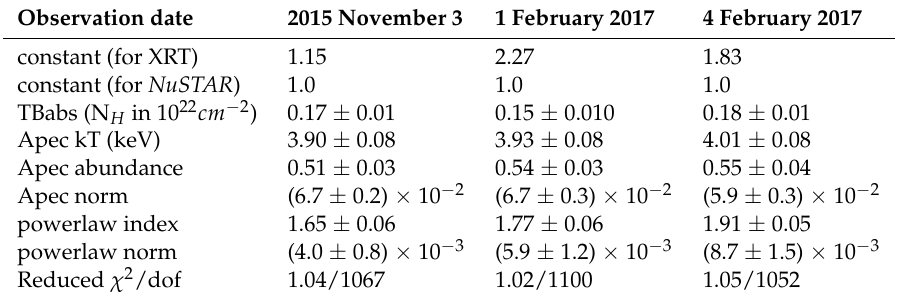
Table 3. Parameters from broad-band spectral fits to the active galactic nucleus (AGN) and cluster data with model constant*tbabs(apec + powerlaw) for XRT- NuSTAR for circular region with radius 1’ around the source. Model parameters were tied and relative normalization was used between XRT and NuSTAR given by the parameter ’constant’.